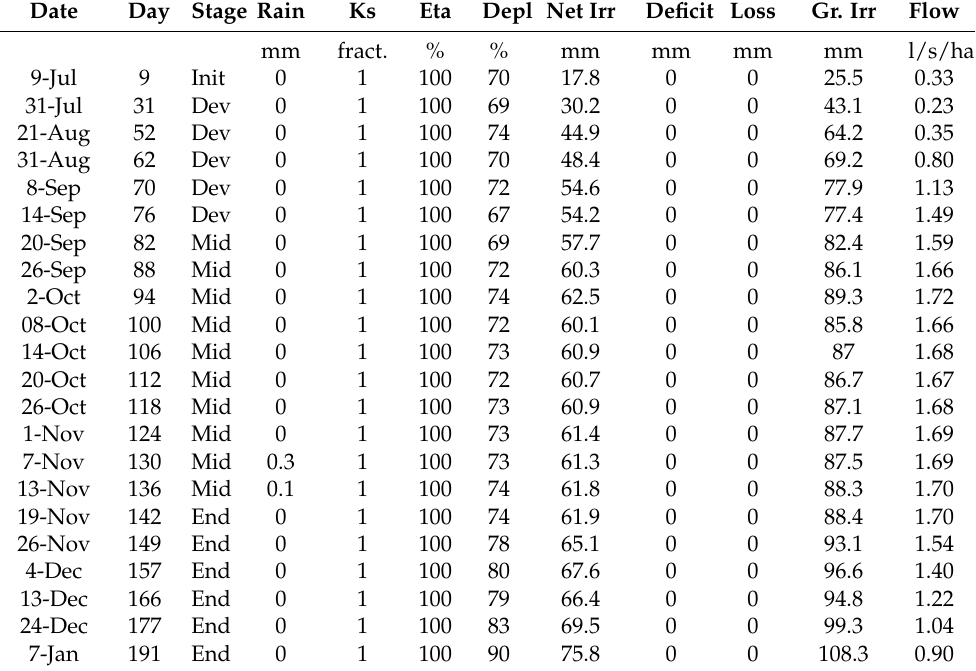
Table 8. Irrigation schedule for